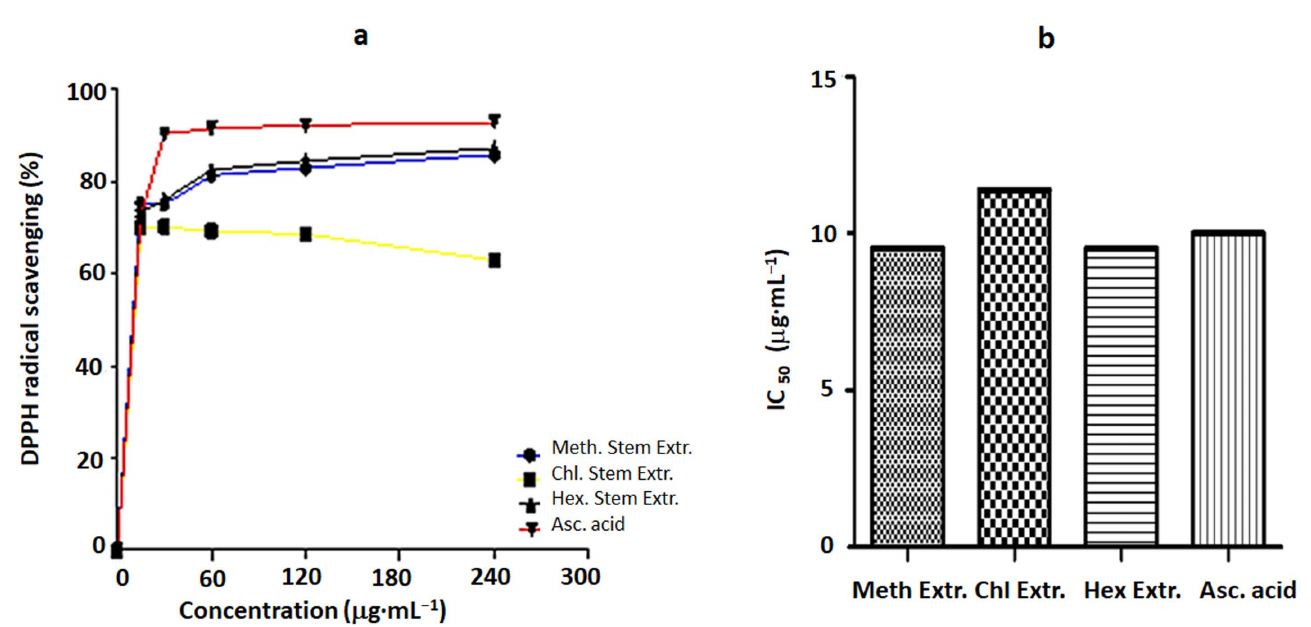
Figure 2. Comparison of DPPH radical ( a ) IC 50 values of D. villosa stem scavenging (%) of D. villosa stem-bark extracts in DPPH radical scavenging assay ( b ). Chl. = Chloroform; Hex = Hexane, Meth. = Methanol; Lv. = leaves; Extr. = Extract; Asc. Acid = Ascorbic